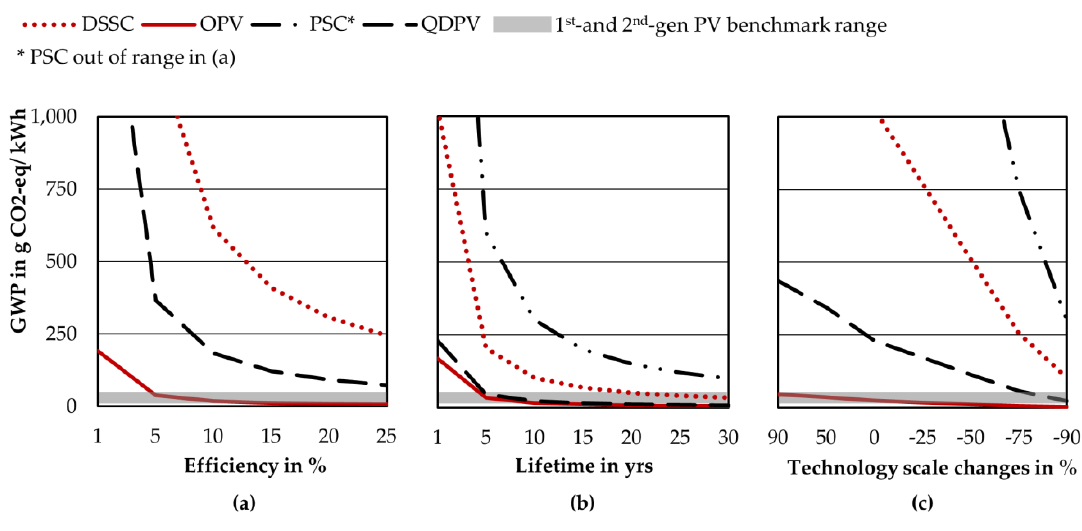
Figure 5. Sensitivity analyses of the prospective development of ( a ) efficiency, ( b ) lifetime, and ( c ) upscaling of the four emerging PVs compared with the range of the benchmarks.